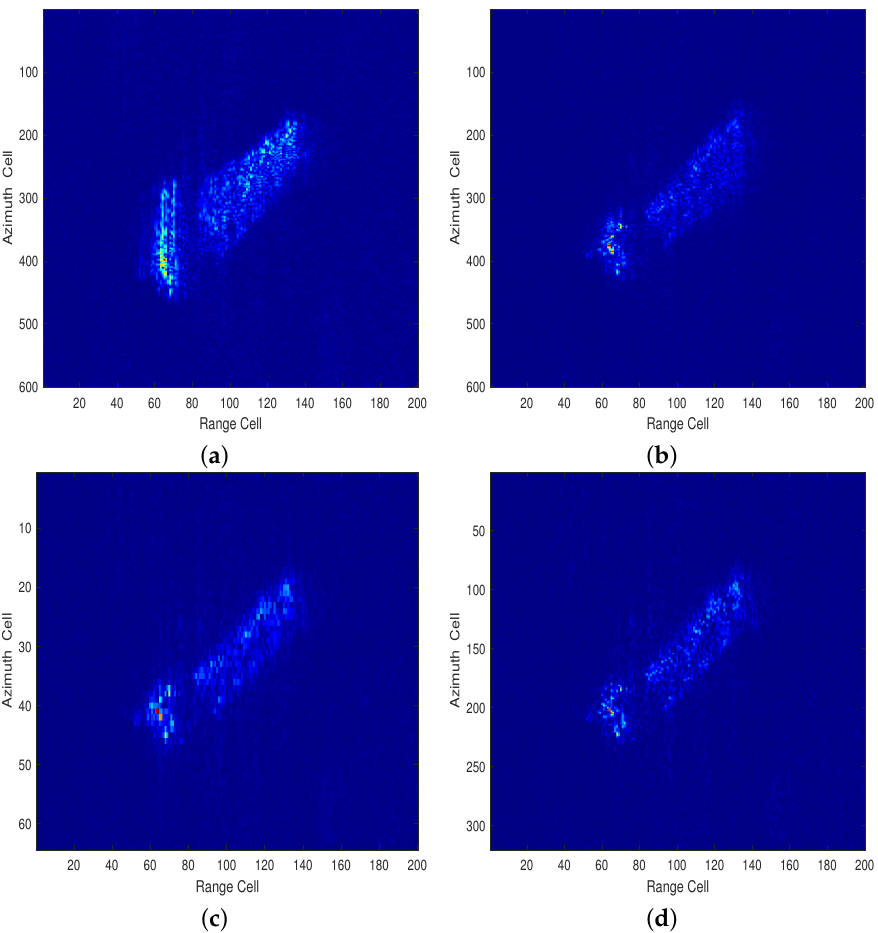
Figure 9. The performance of the proposed method on rotating ship 1. ( a ) SAR subimage. ( b ) RD imaging after motion compensation. ( c ) RD imaging after optimal imaging time selection. ( d ) IAA imaging after optimal imaging time selection.